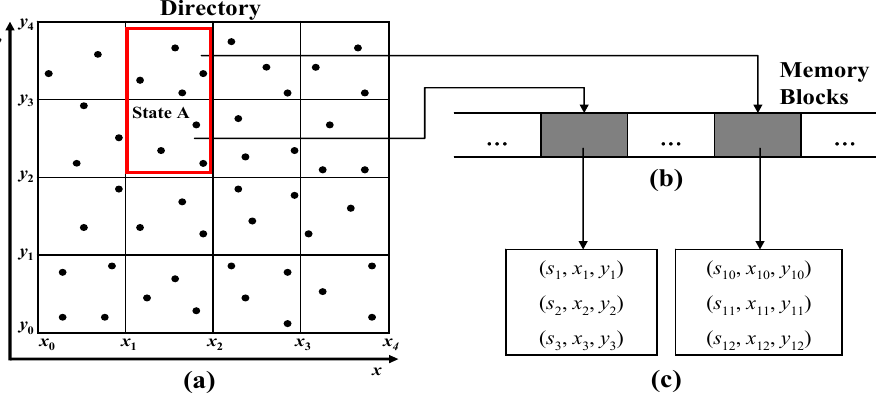
Figure 5. Spatial mapping for searching for the locations of sensors. ( a ) directory of fixed grid for location mapping; ( b ) memory blocks referenced by the directory; ( c ) item set in memory